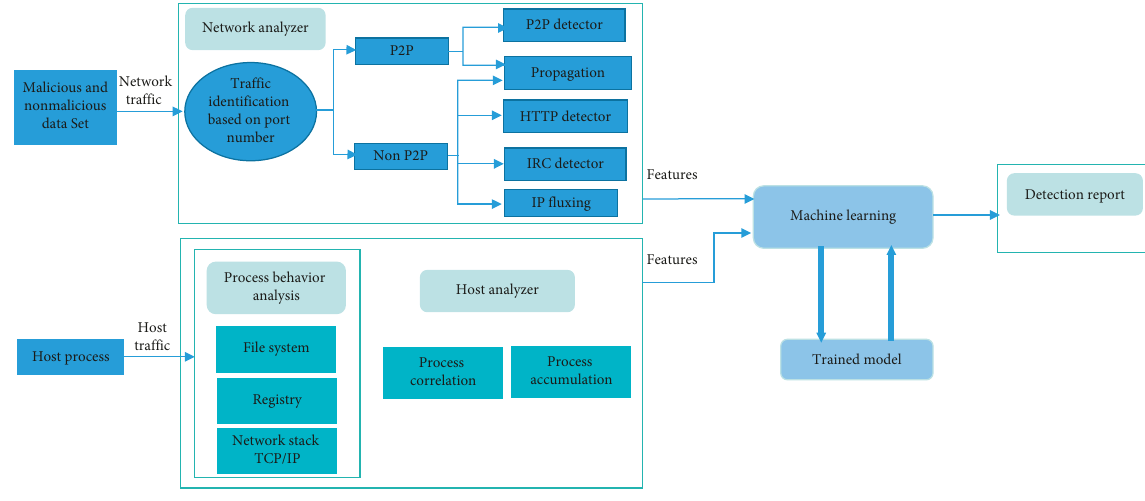
Figure 3: HANABot